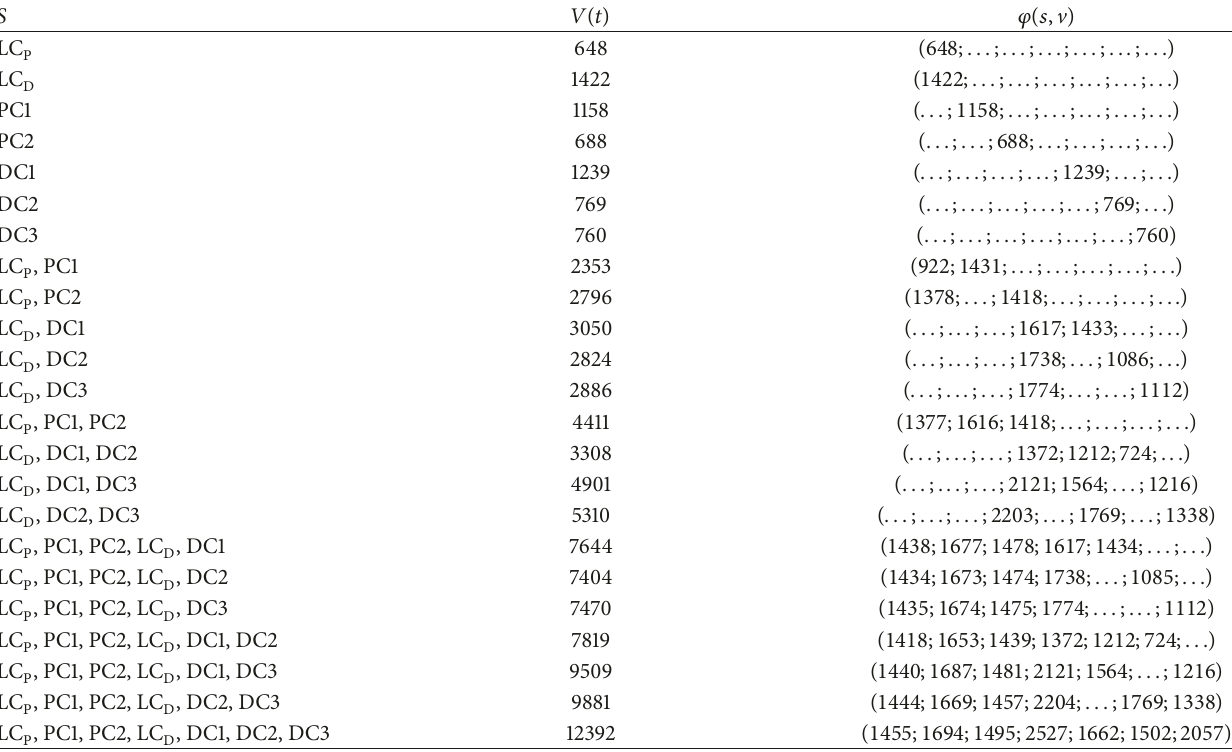
Table 7: Profit allocation in two-echelon logistics distribution network.